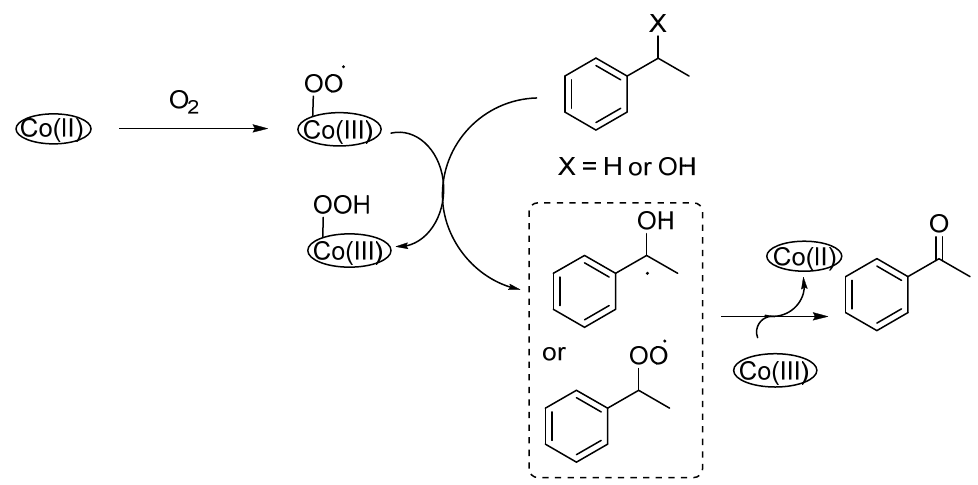
Figure 22. Proposed mechanism for akyl arenes and alcohols aerobic oxidation (adapted from [72]).